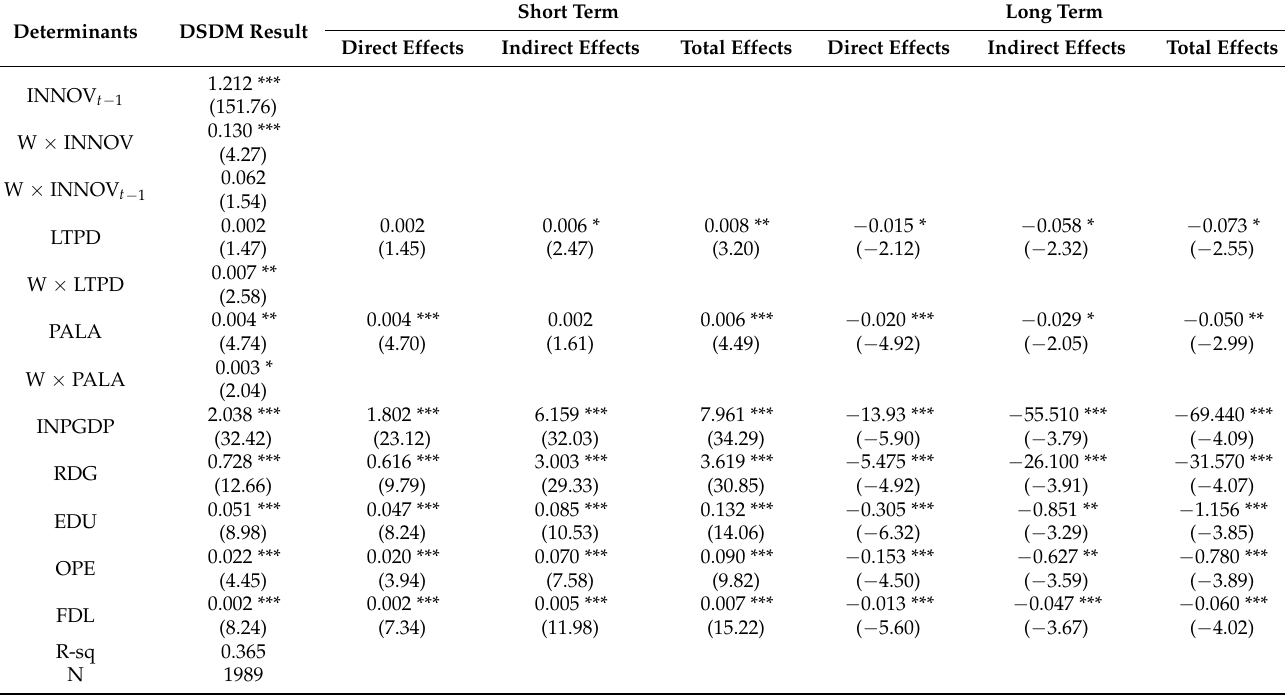
Table 7. Results of regression and effects decomposition for Midwest